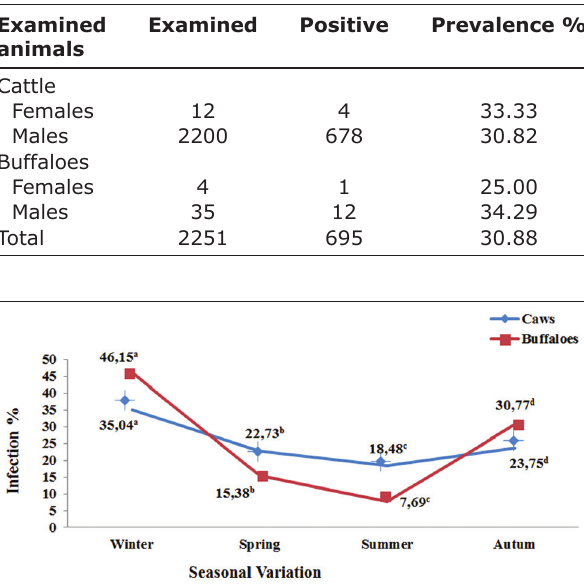
Table-1: Prevalence of liver fascioliasis in examined cattle and buffaloes slaughtered at the municipal abattoir of El-Kharga.